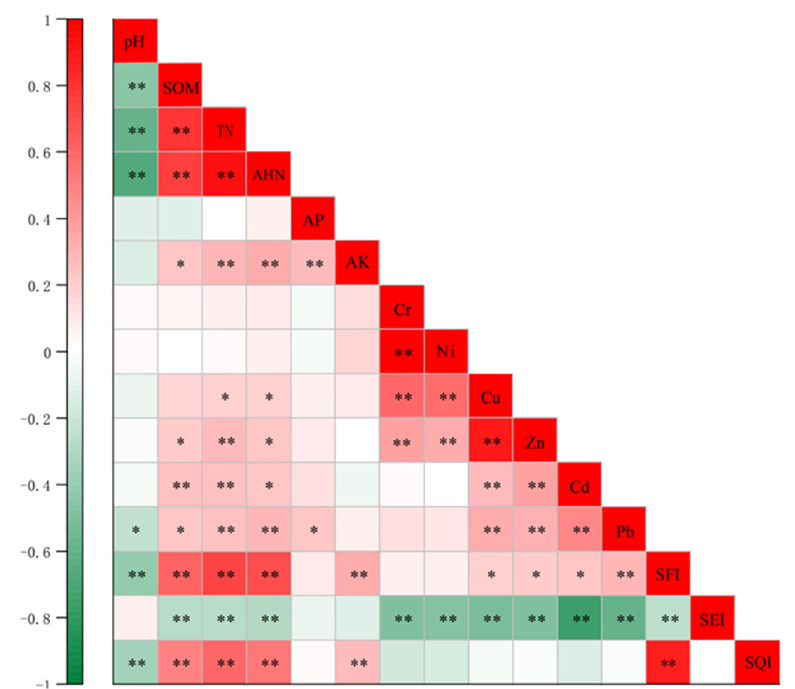
Figure 6. Correlation analysis between different soil indicators. * Significant at the p < 0.05 level. ** Significant at the p < 0.01 level. ** Significant at the p < 0.01